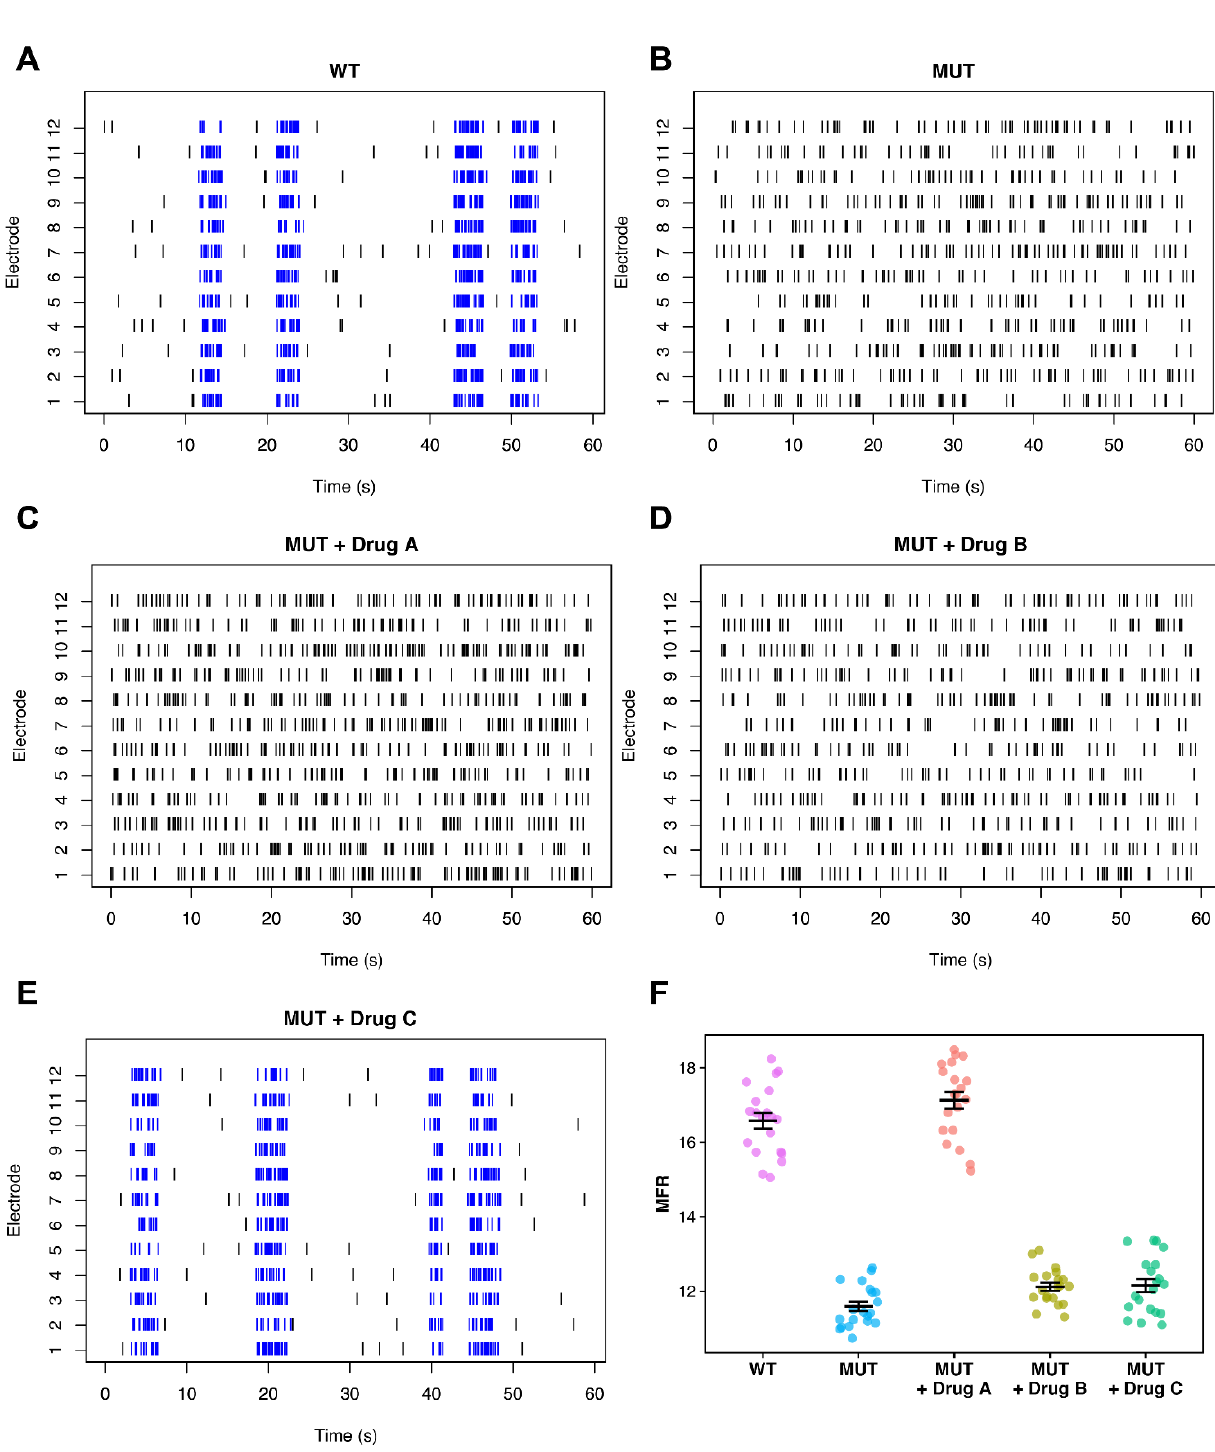
Figure 3. Importance of representative raster plots in phenotypic rescue experiments. Representative raster plots from hypothetical wild-type ( A ) and mutant ( B ) networks, as well as mutant networks treated with three theoretical drug compounds ( C – E ). ( F ) Quantification of mean firing rates for each group.